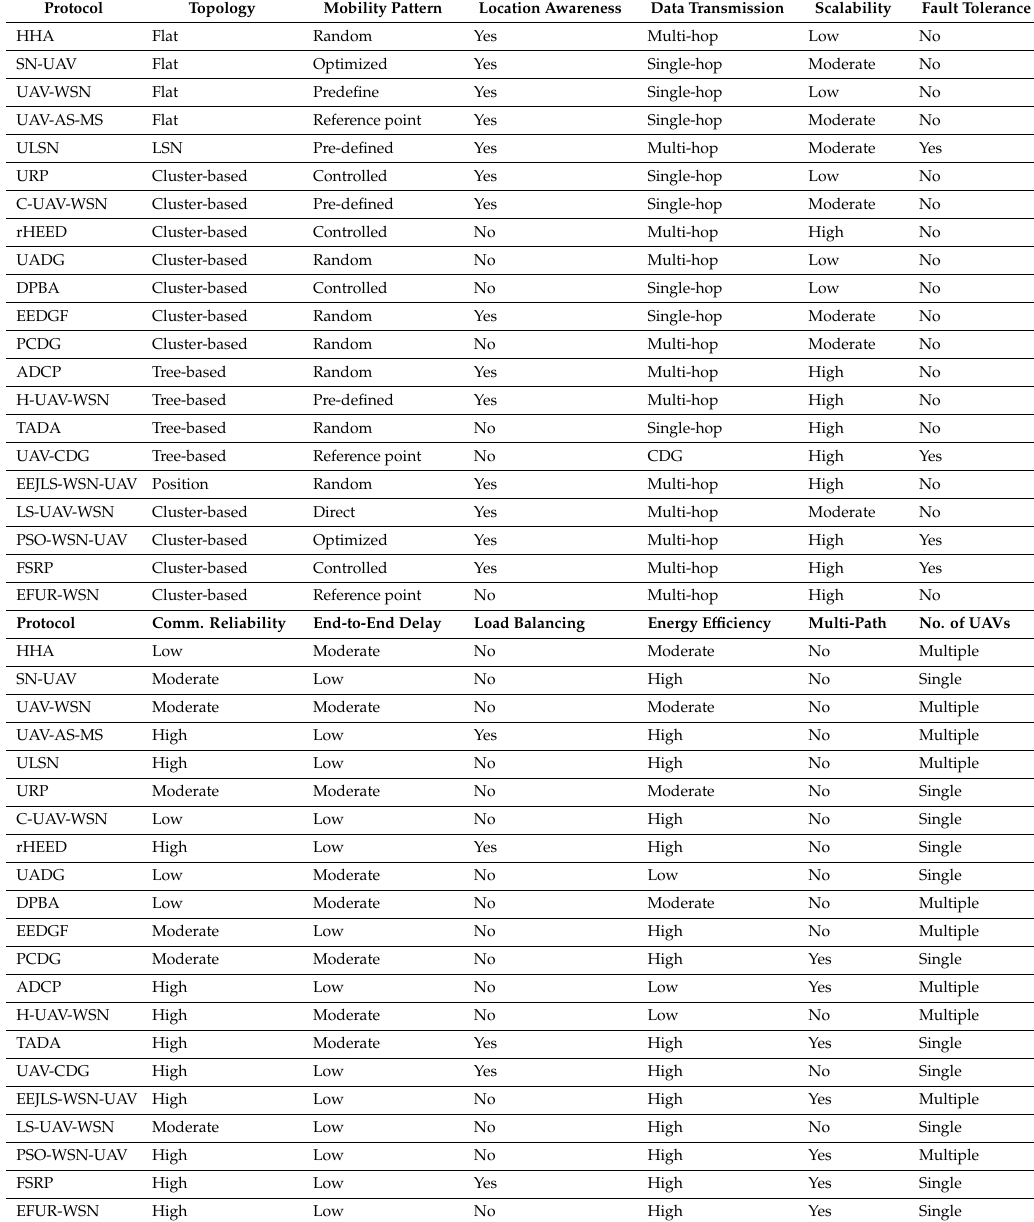
Table 4. Comparison of routing protocols for